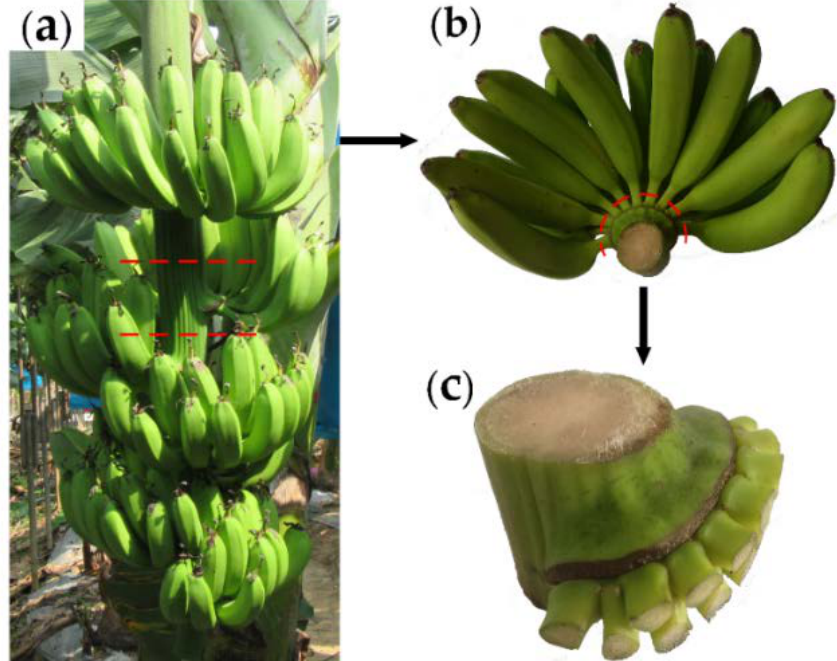
Figure 1. Banana crown preparation processes. ( a ) Banana bunch; ( b ) banana hand; ( c ) banana crown. Red lines are used to mark where the knife cut in Figure 1a,b.